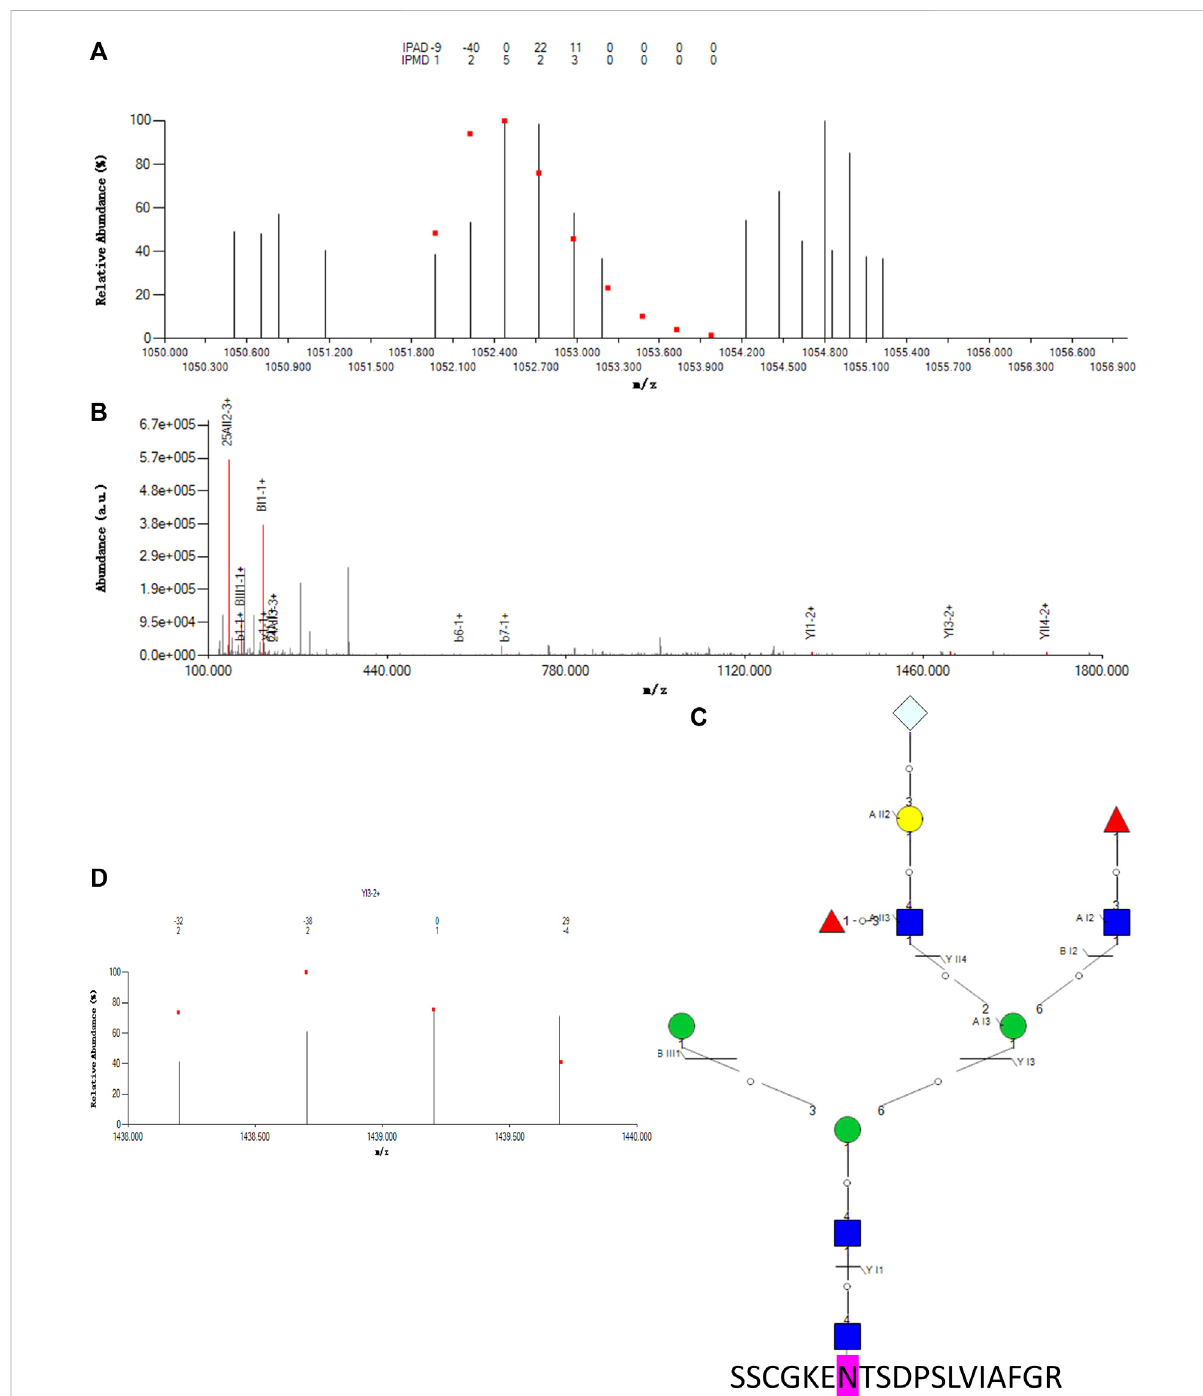
FIGURE 3 Example intact N-glycopeptide SSCGKENTSDPSLVIAFGR with a complex N-glycan 01Y41Y41M(31M)61M(21Y(31F)41L32T)61Y31F containing Neu5Gc identi fi ed from N-glycosite N84 of lysosome-associated membrane glycoprotein 1 (LAMP1_HUMAN, P11279). (A) Theoretical (dots) and experimental isotopic envelope fi ngerprinting map of the precursor ion. (B) Annotated MS/MS spectrum with the matched fragment ions from both the peptide backbone and N-glycan moiety. (C) Graphical fragmentation map of the N-glycan moiety. (D) Theoretical (dots) and experimental isotopic envelope fi ngerprinting map of the structure-diagnostic fragment ion YI3. = N-acetylglucosamine (Y), = mannose (M), = galactose (L), = fucose (F), = N-acetylneuraminic acid (S), = N-glycolylneuraminic acid (T); IPAD = isotopic peak abundance deviation, IPMD = isotopic peak M/z deviation; a.u. = arbitrary